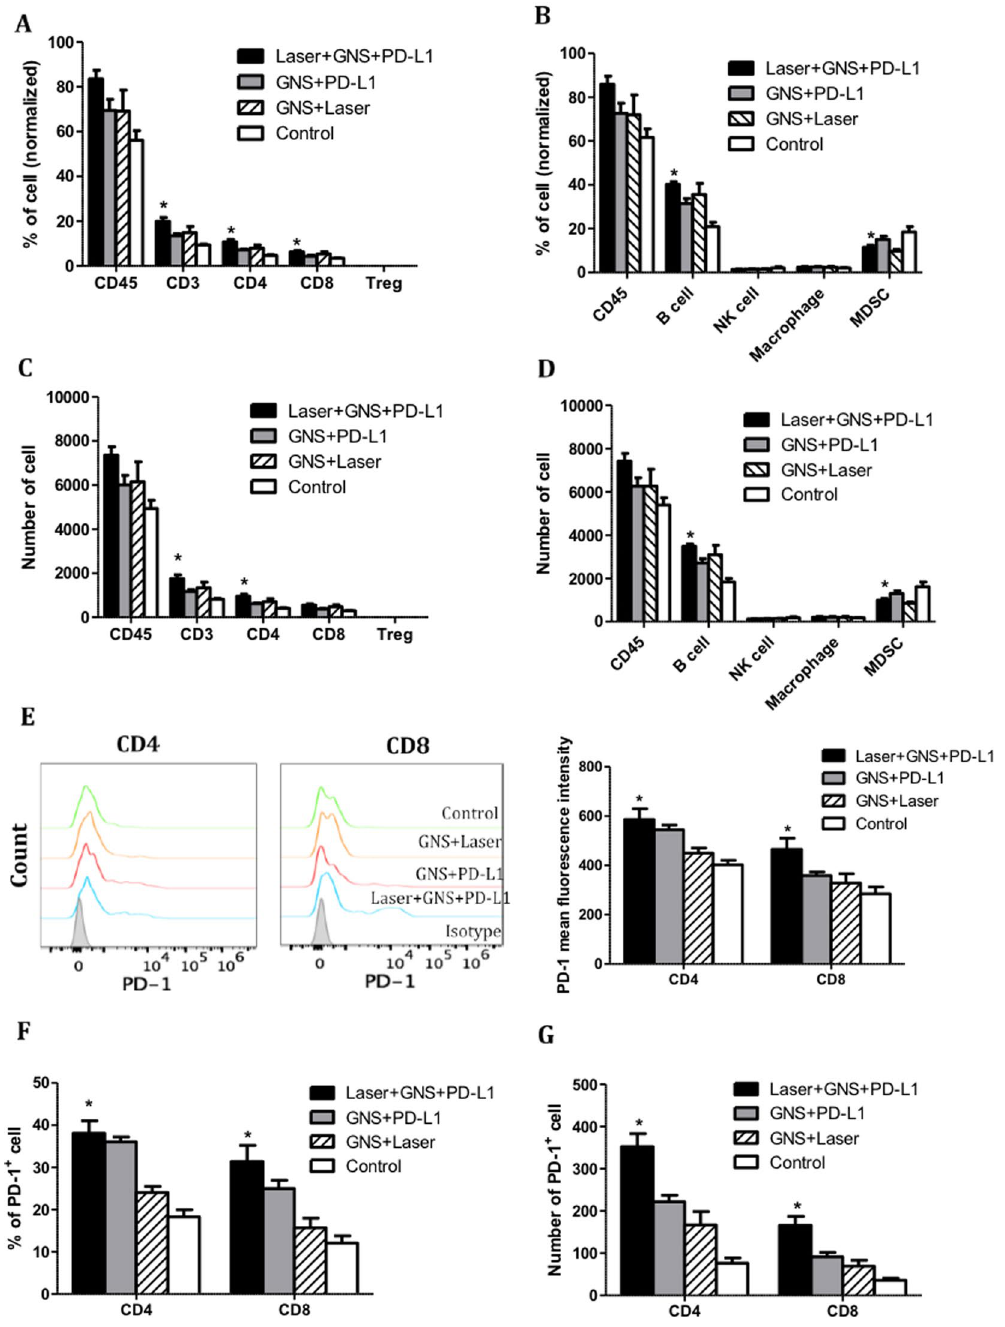
Figure 4. Immune cell phenotyping in the spleen. Single cell suspensions were processed from the spleen. ( A,B ) The percentage and ( C , D ) absolute cell number of total leukocytes (CD45), total T cells (CD3), CD4, CD8, T regulatory cells (CD4/CD25/FOXP3) and (B) B cells (CD19), NK cells (CD335), macrophages (CD11b/ F4/80) and MDSC (CD11b/Gr1) were analyzed by flow cytometry. The percentage of cells was normalized to total single cells in each sample. ( E ) Mean fluorescence of PD-1 expression on CD4 and CD8 T cells. (F ) The percentage and ( G ) absolute cell number of PD-1 + CD4 and PD-1 + CD8 T cells. * p < 0.05, compared to control group. One-way ANOVA analysis was